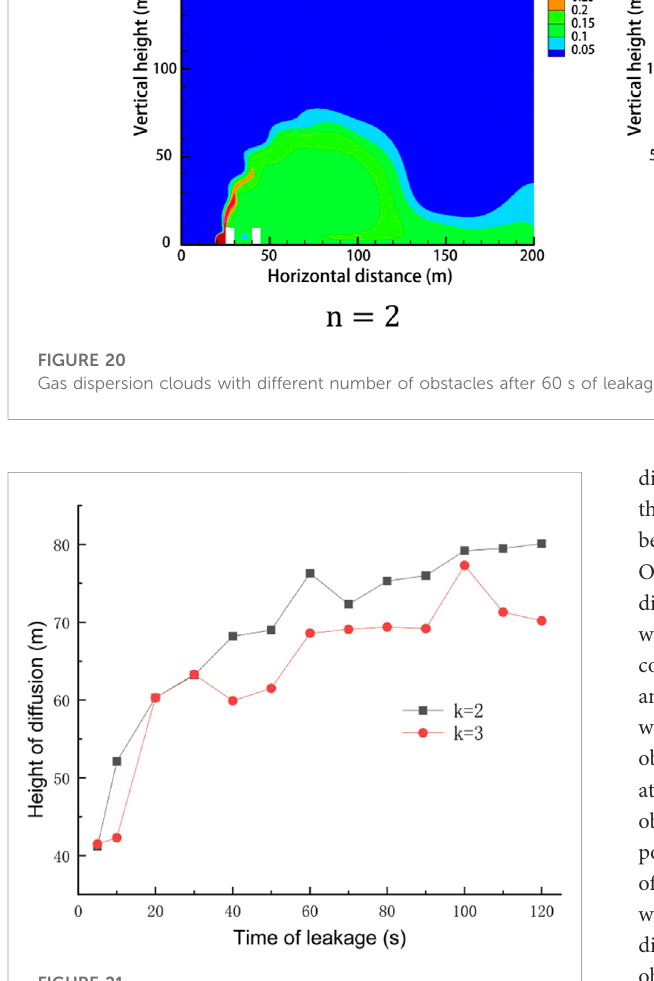
FIGURE 21 Diffusion height at different times for different number of